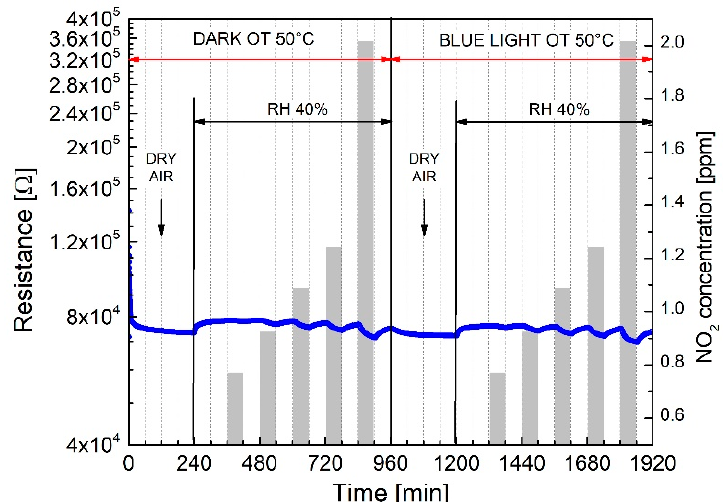
Figure 9. The influence of 40% Relative Humidity (40% RH) on the NO 2 response of WS 2 -decorated rGO under dark and light illumination at 50 °C operating temperature.